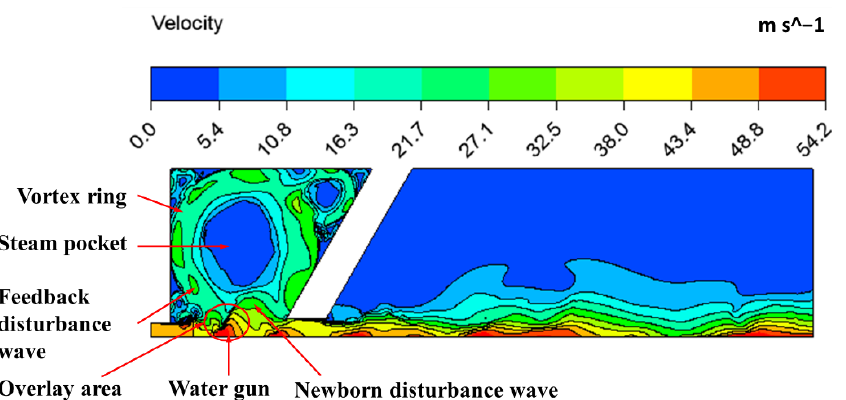
Figure 7. Velocity contours in the SOC.